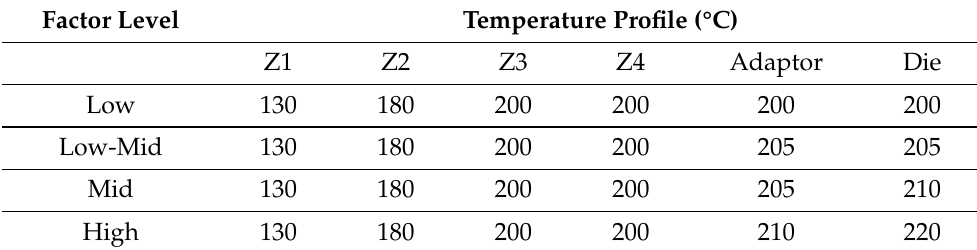
Table 2. Factor levels for the temperature profile in runs 25–30 (independent external test set).